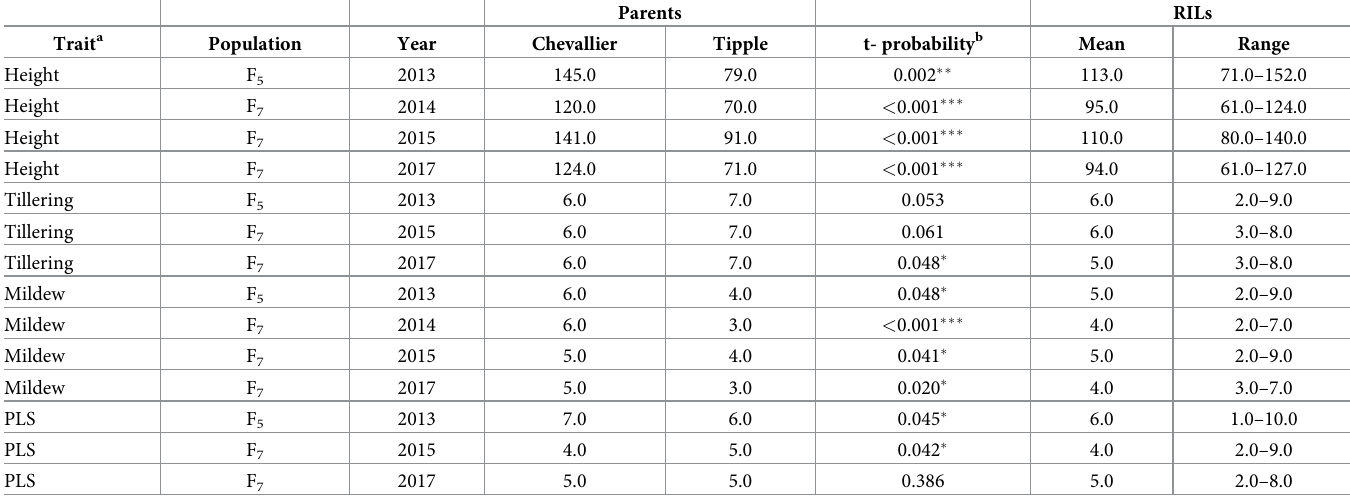
Table 1. Predicted mean values from general linear modelling (GLM) of phenotypic traits for Chevallier and Tipple, and the range of predicted means of the Chevallier × Tipple F 5 and F 7